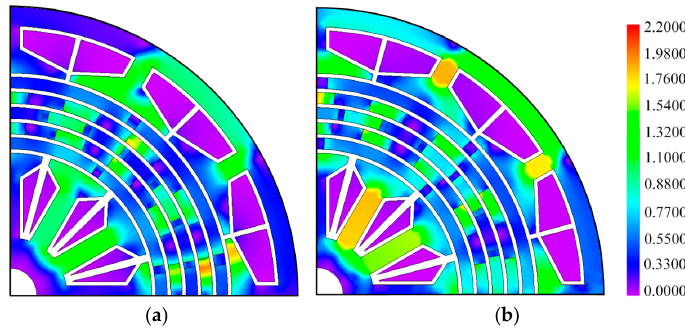
Figure 10. Magnetic flux density distribution: ( a ) Without load; ( b ) With load.